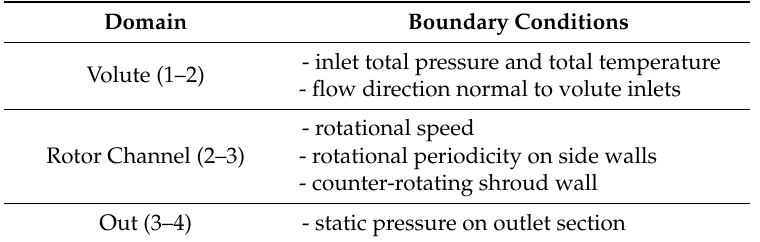
Table 1. CFD model boundary conditions. Numbers define ‘in-out’ control sections for each domain.